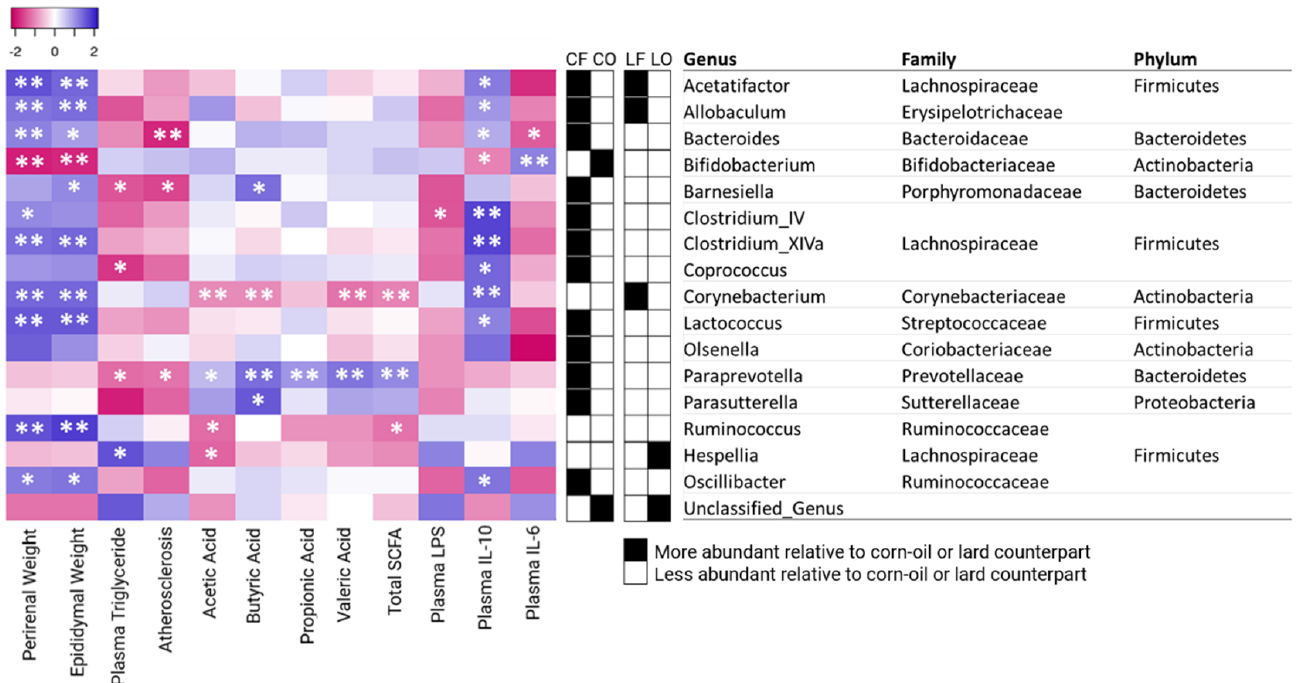
Figure 11. Spearman’s correlation heatmap of major genera with key indices. Hamsters were fed one of the four diets: CF, fresh corn oil; CO, oxidized corn oil; LF, fresh lard; LO, oxidized lard. Correlation significance is indicated by asterisks (“*” reflects p < 0.05, “**” p < 0.01). Filled box (▪) represents a corn oil or lard group that has a significantly greater abundance of bacteria relative to its counterpart ( p < 0.05). Unfilled box (▫) represents a corn oil or lard group that has a significantly lower abundance of bacteria relative to its counterpart ( p < 0.05). Taxonomic information (phylum, family) is provided on the right.